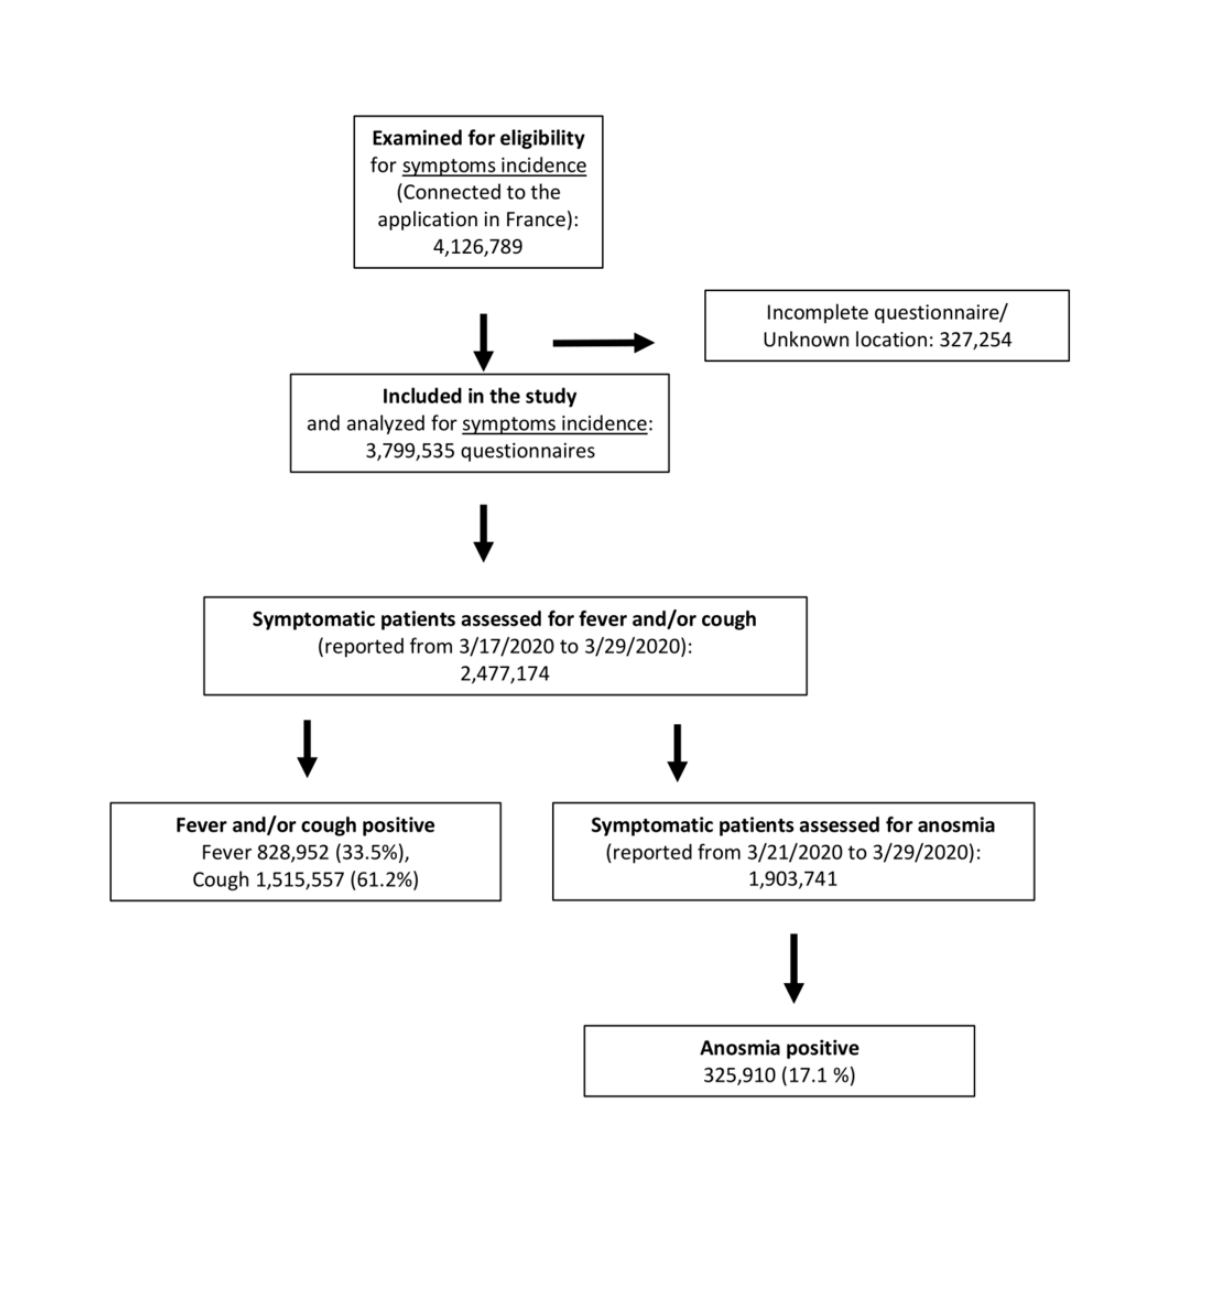
Figure 1. Flowchart of the study